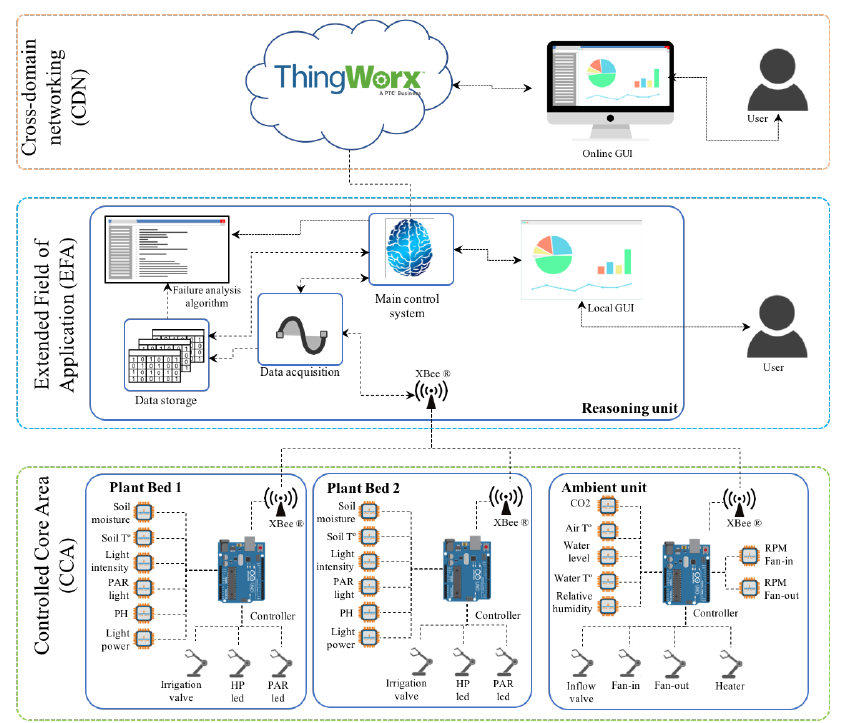
Figure 9. Architecture of the testbed.